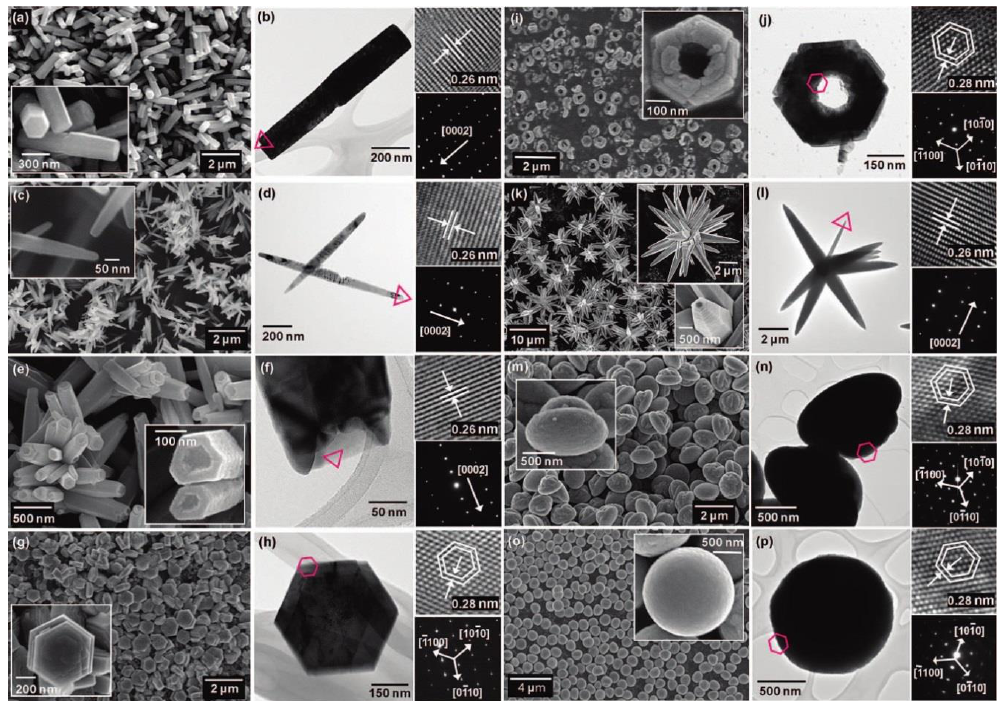
Figure 20. SEM ( left ) and TEM ( right ) images of the basic ZnO structures synthesised by the microwave irradiation: ( a , b ) nanorods, ( c , d ) nanoneedles, ( e , f ) nanocandles, ( g , h ) nanodisks, ( i , j ) nanonuts, ( k , l ) microstars, ( m , n ) microUFOs, ( o , p ) microballs. HRTEM images and SAED patterns were inserted as upper and lower insets in TEM images, respectively. The HRTEM images were obtained at the centre of the triangles or the hexagons in the TEM images. Reprinted (adapted) with permission from